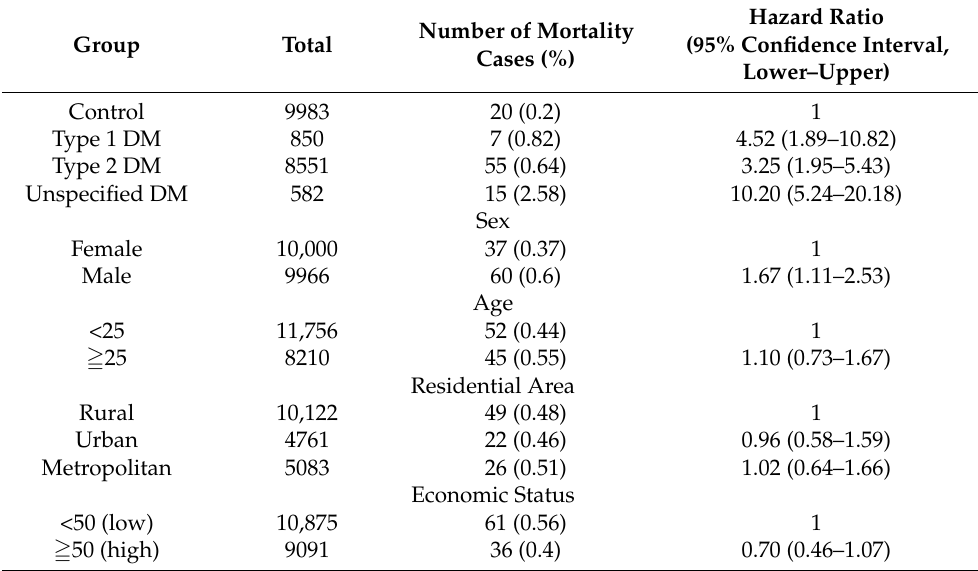
Table 2. Mortality and hazard ratios for death during the 12 yr study